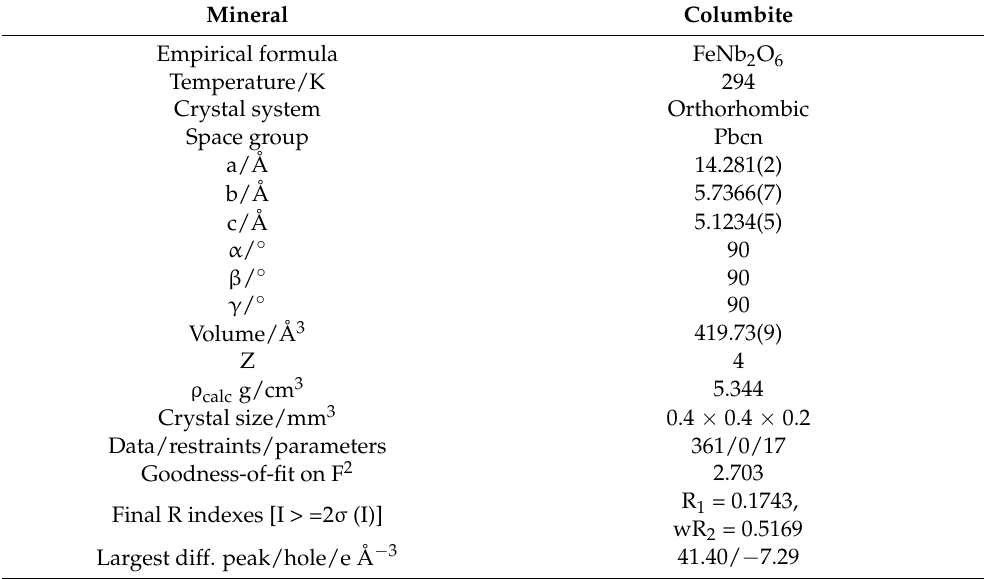
Table 1. Single crystals X-ray diffraction results for all measured minerals. Mineral Columbite Empirical formula FeNb 2 O 6 Temperature/K 294 Crystal system Orthorhombic Space group Pbcn a/Å 14.281(2) b/Å